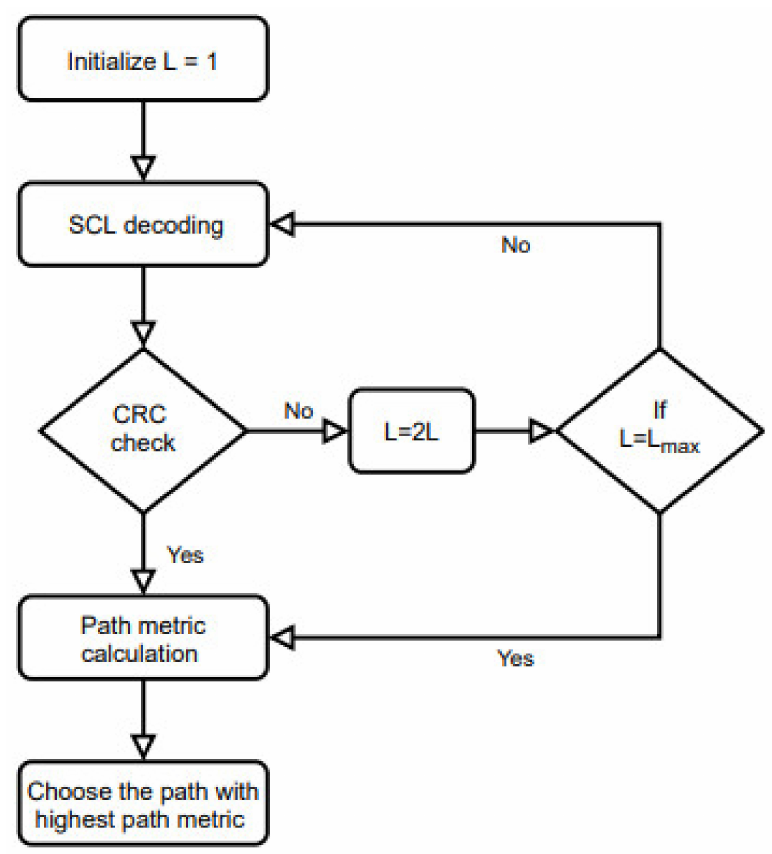
Figure 3. Adaptive SCL Decoder